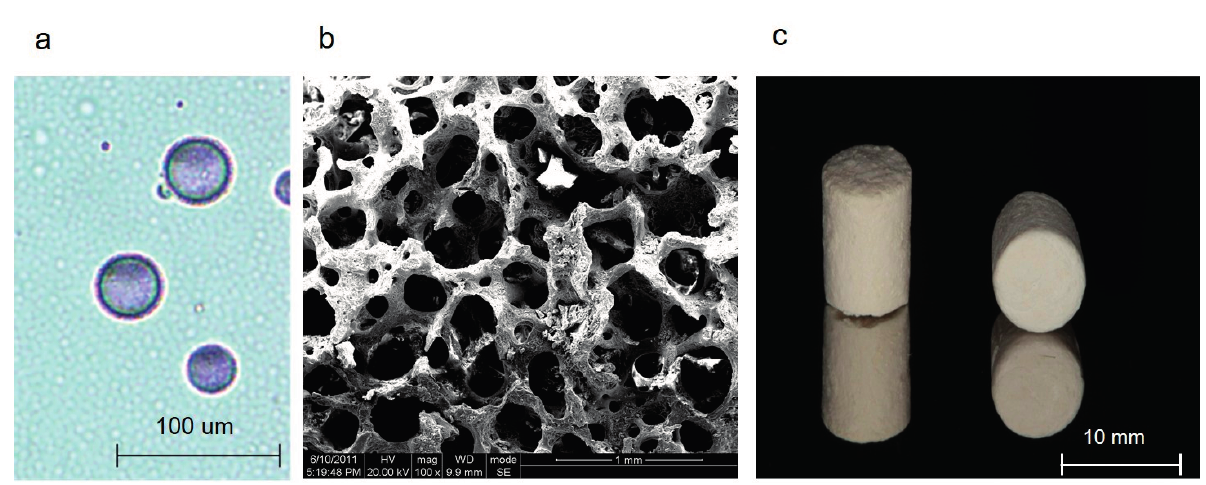
Figure 1. Optical microscopic (Nikon, Berlin, Germany) image (( a ) scale bars = 100 µm) of chitosan microspheres with gAPN (blue purple); SEM image of the β -TCP scaffold (( b ) scale bars = 1 mm, particle size 0.25–1 mm, pore size 100–600 μ m) prepared in the PLGA (poly L -lactic- co -glycolic acid) scaffold. The appearance of PLGA scaffold (( c ) scale bars = 10